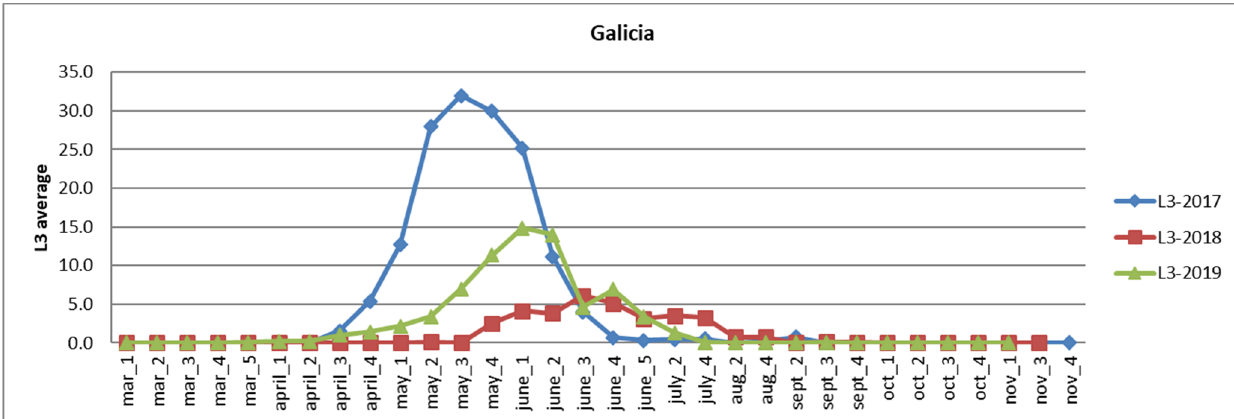
Figure 11. Evolution of the average number of larvae in stage L4, according to the week of the survey month. Figure 12 show the evolution of the variable mean values for the number of oothecae collected by date of visit or survey, according to data from the Xunta data. The mean val- ues were obtained because the total number of oothecae per survey corresponded to counts from a different number of plots each time. Figure 12. Number of oothecae according to the week in the sampling month (survey).